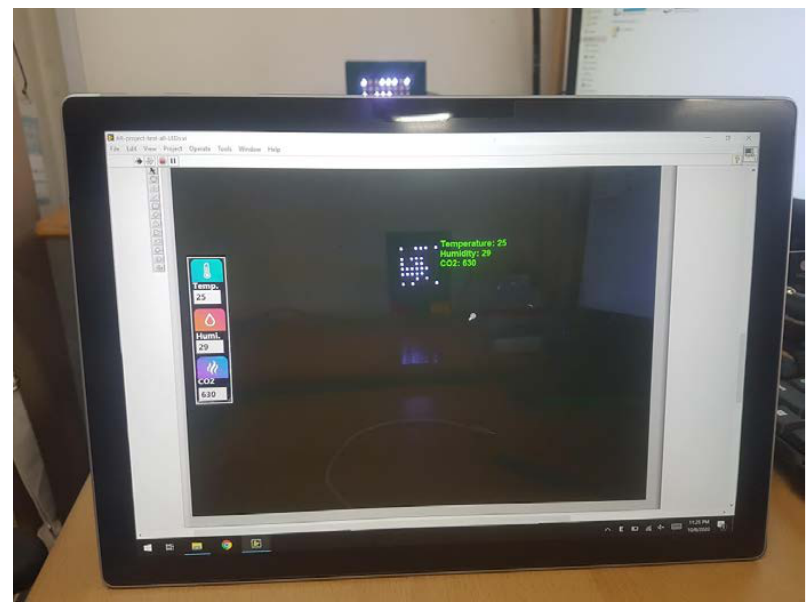
Figure 16. Rx interface with the rear camera of tablet. Table 1. Characteristic parameters of the proposed scheme.